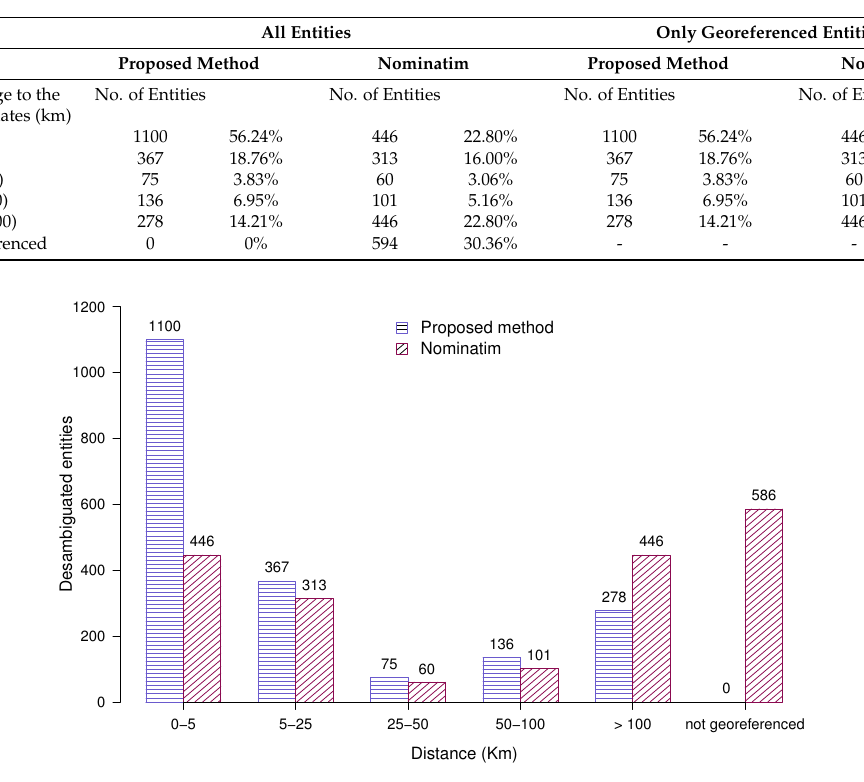
Figure 4. Frequencies of toponyms in ranges according to their distances to the actual points for all entities.